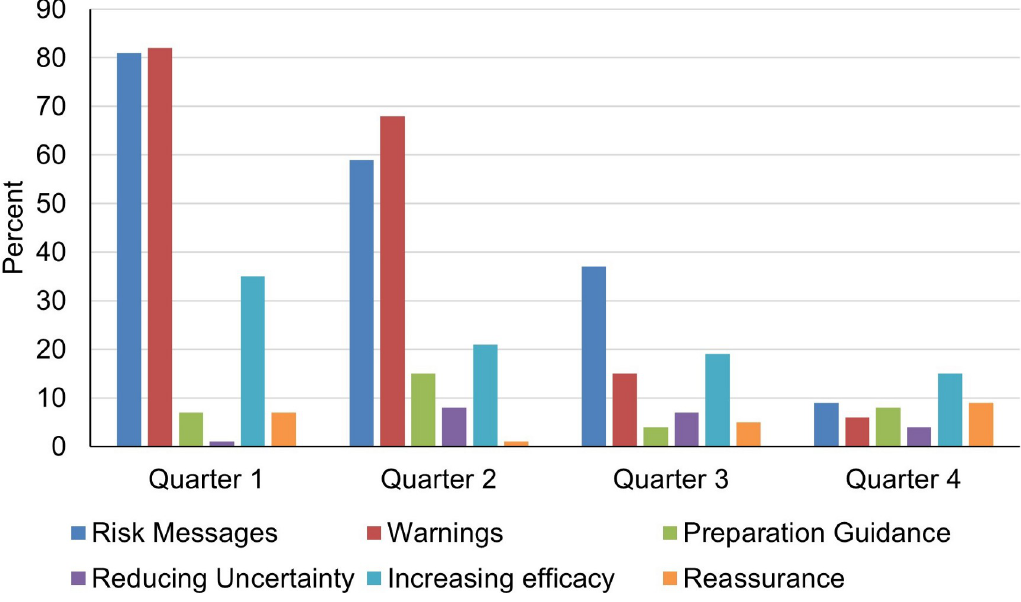
Fig 5. Quarterly Crisis and Emergency Risk Communication (CERC) Model themes (about Zika and dengue) found in government health agency (i.e., CDC, FDA, NIAID, NIH) Facebook posts during